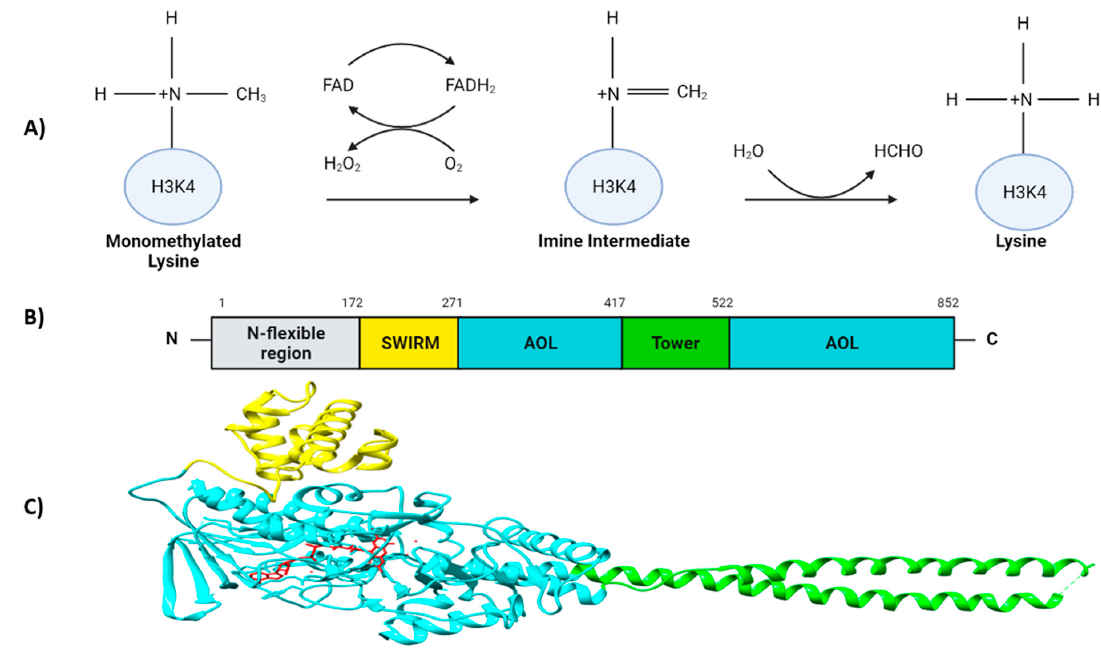
Figure 1. Overview of the demethylation process and the LSD1 structure. ( A ) LSD1-mediated demethylation of monomethylated H3K4. ( B ) Domain organization of human LSD1 depicting the N-flexible region (grey), the SWIRM domain (yellow), the AOL domains (cyan), and the Tower domain (green). ( C ) Overall structure of LSD1. The SWIRM (yellow), AOL (cyan) and Tower domain (green) are represented. The catalytic center of LSD1 located inside of the two AOL subdomains is colorized in red.